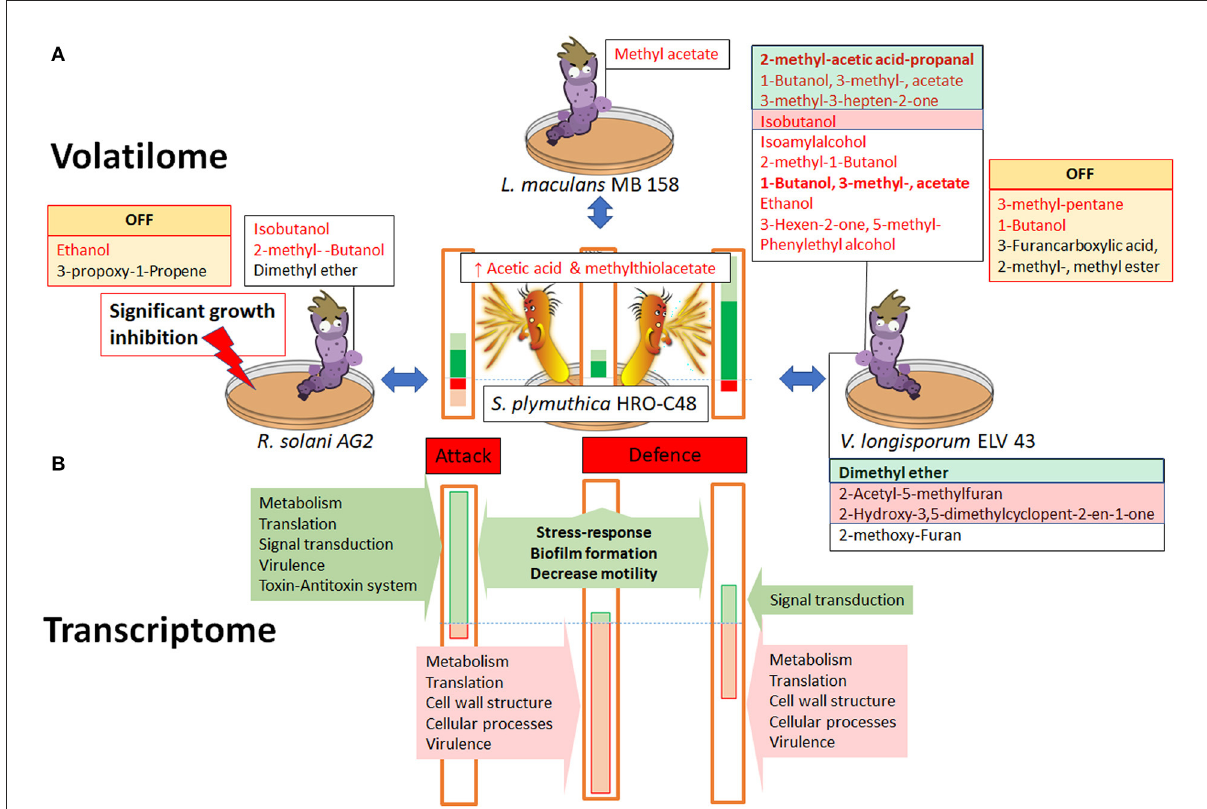
FIGURE5 Volatile in vitro interactions between S. plymuthica HRO-C48 and the fungal plant pathogens R. solani AG2, L. maculans MB 158 and V. longisporum ELV 43. Panel (A) shows the interactions on the level of the volatilome and growth inhibition. Significantly up- or downregulated volatiles produced by fungi are highlighted in green and red, respectively. Those volatiles that were “switched off” in the respective volatilome compared to the untreated control, are labeled with “OFF” sign. Changes in the bacterial volatilome are shown schematically as colored bars (green upregulated, red downregulated). The heights of the bars correspond with the proportion of up- (green) or down (red) regulated VOCs, while VOCs with predicted antimicrobial effects are shown in dark green or red, respectively. Panel (B) shows the proportion of up- and downregulated genes involved in different metabolic functions in S. plymuthica HRO-C48 due to exposure to volatiles of the three selected fungi as detected by the transcriptomic analysis. The dashed lines indicate the borders between up and downregulated substances. Please see corresponding Supplementary Tables S2–S4 for the exact substance names and references. The correspondence of the gene and VOCs expression changes to the “defense” and “attack” modes was extrapolated based on the available